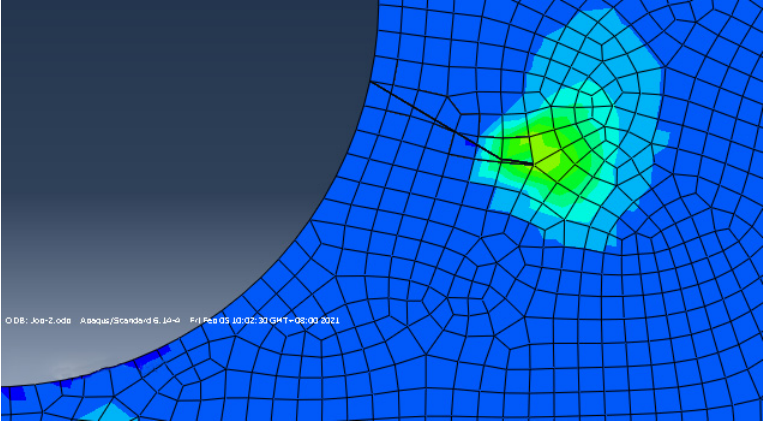
Figure 3. Crack growth model.